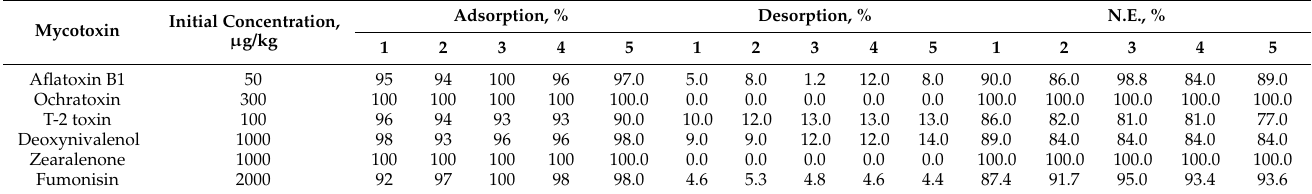
Table 3. Data on sorption and desorption of mycotoxins.